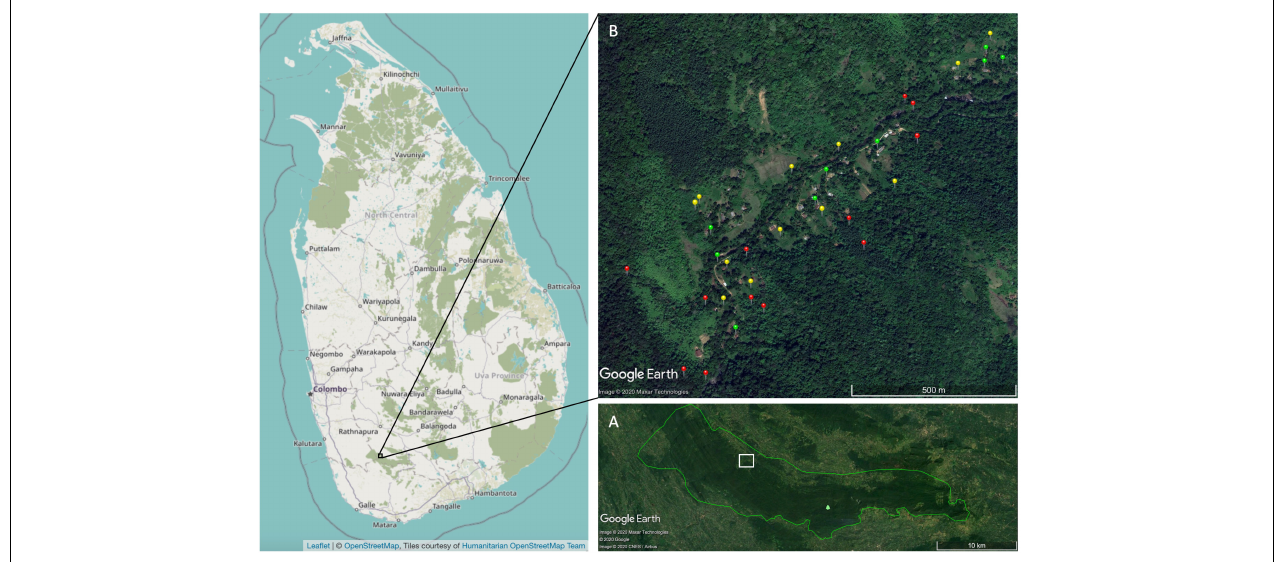
FIGURE 1 | (A) Pitakele is located in southwest Sri Lanka. Satellite imagery via Google Earth clearly shows the dark band of the protected Sinharaja rainforest. (B) Bird point counts follow the Pitakele river valley. Green pins are tree gardens, yellow pins are tea, and red pins are forest fragment. Pitakele is embedded in the Sinharaja. Adapted from Google Earth and Open Street Map.